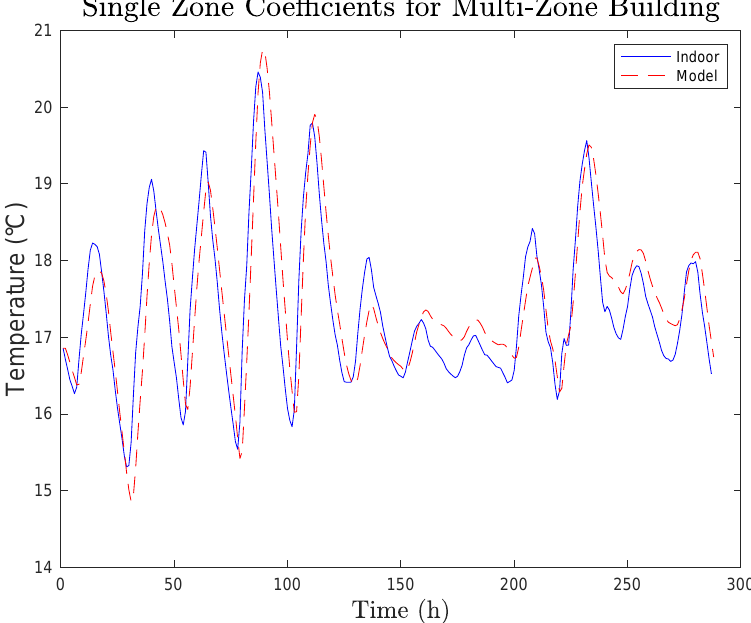
Figure 10. Single zone coefficients fit to a multi-zone building using the second order